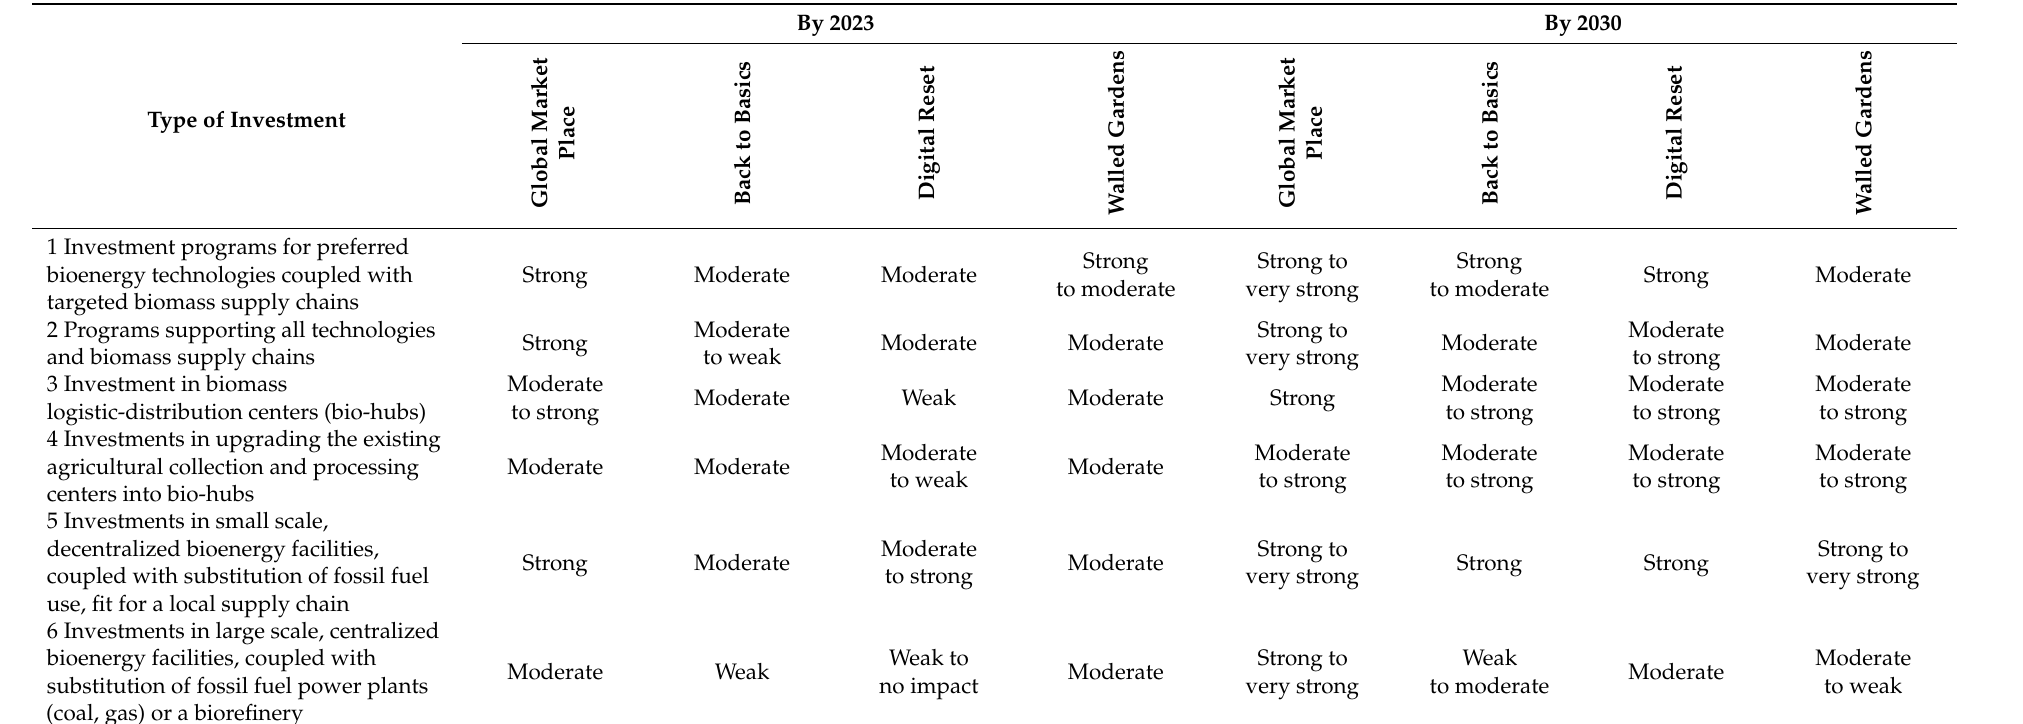
Table A7. Expert consensus on impact of investments in technology and infrastructure on economic growth